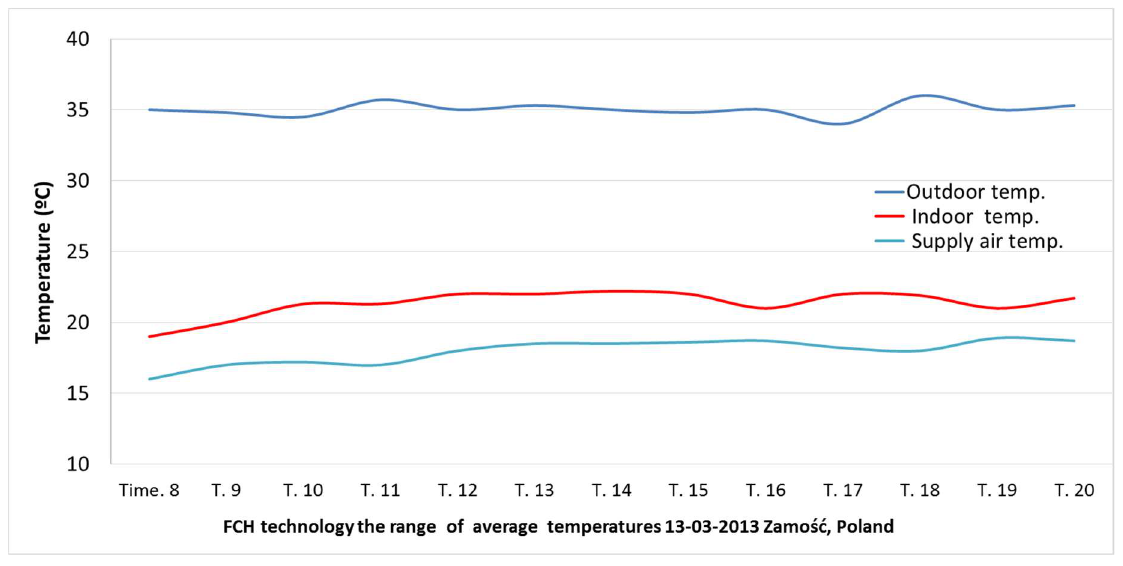
Figure 9. Temperature chart at outdoor temperature Tz = 36 °C, FCH technology, the range of average temperatures (13 March 2013), Zamość, Poland.